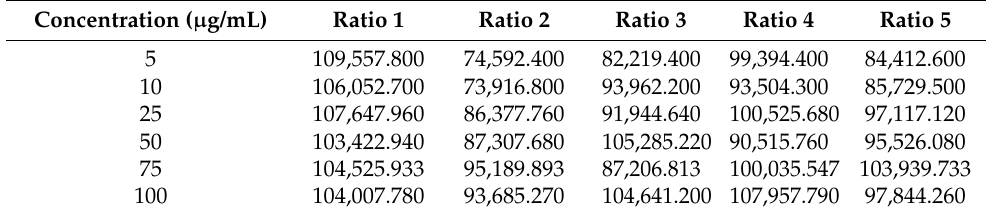
Table 4. Standard APR curve and respective area response factor. High